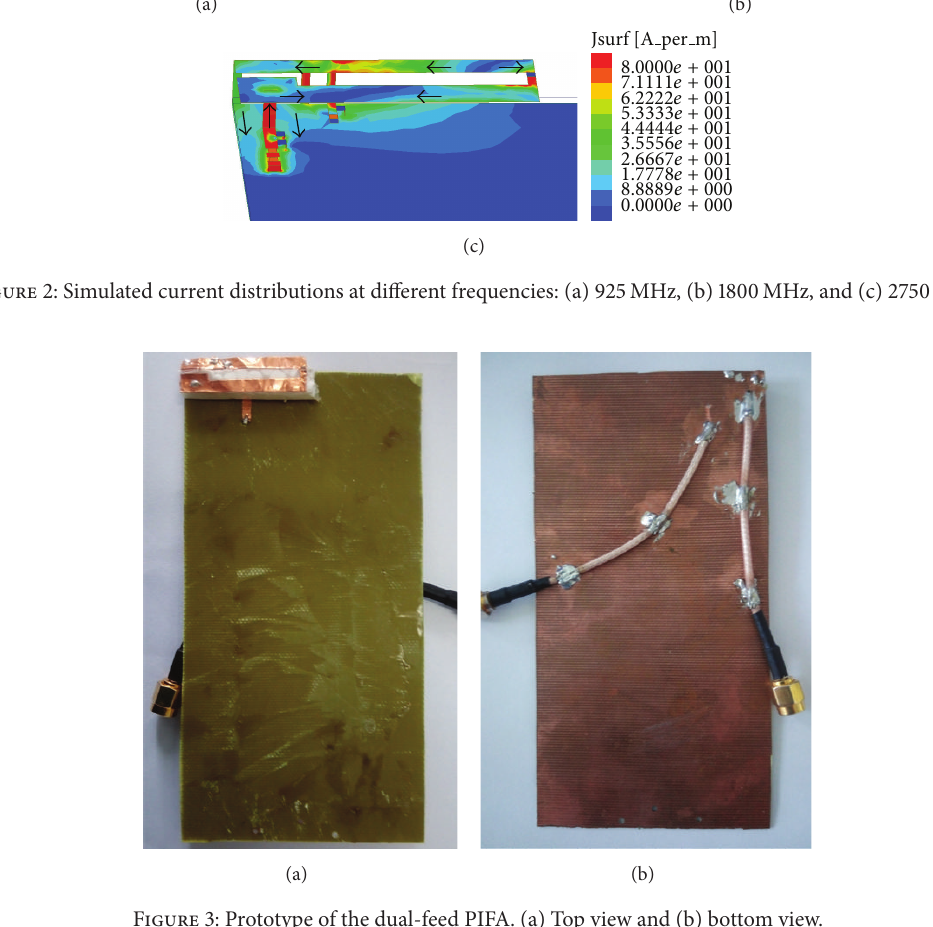
Figure 3: Prototype of the dual-feed PIFA. (a) Top view and (b) bottom